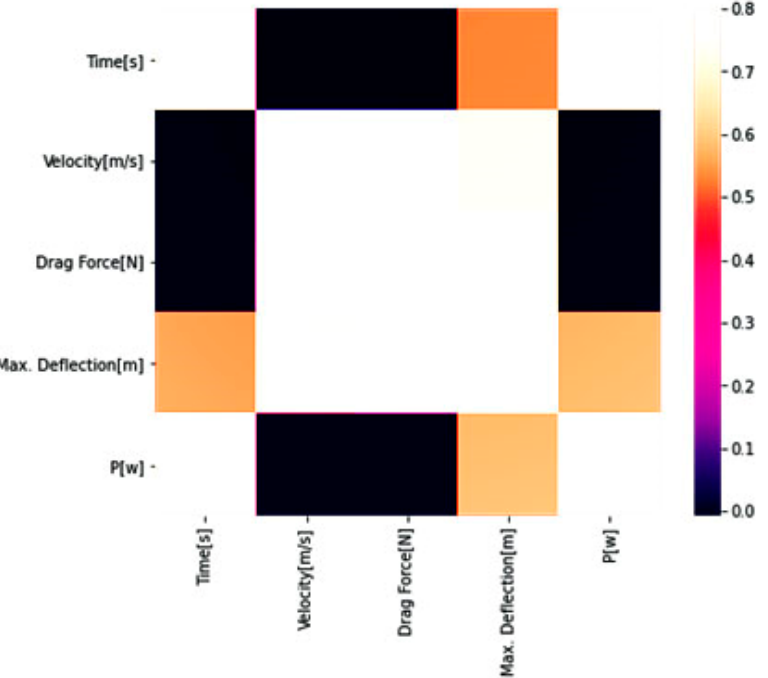
Figure 6. The correlation matrix of different parameters.